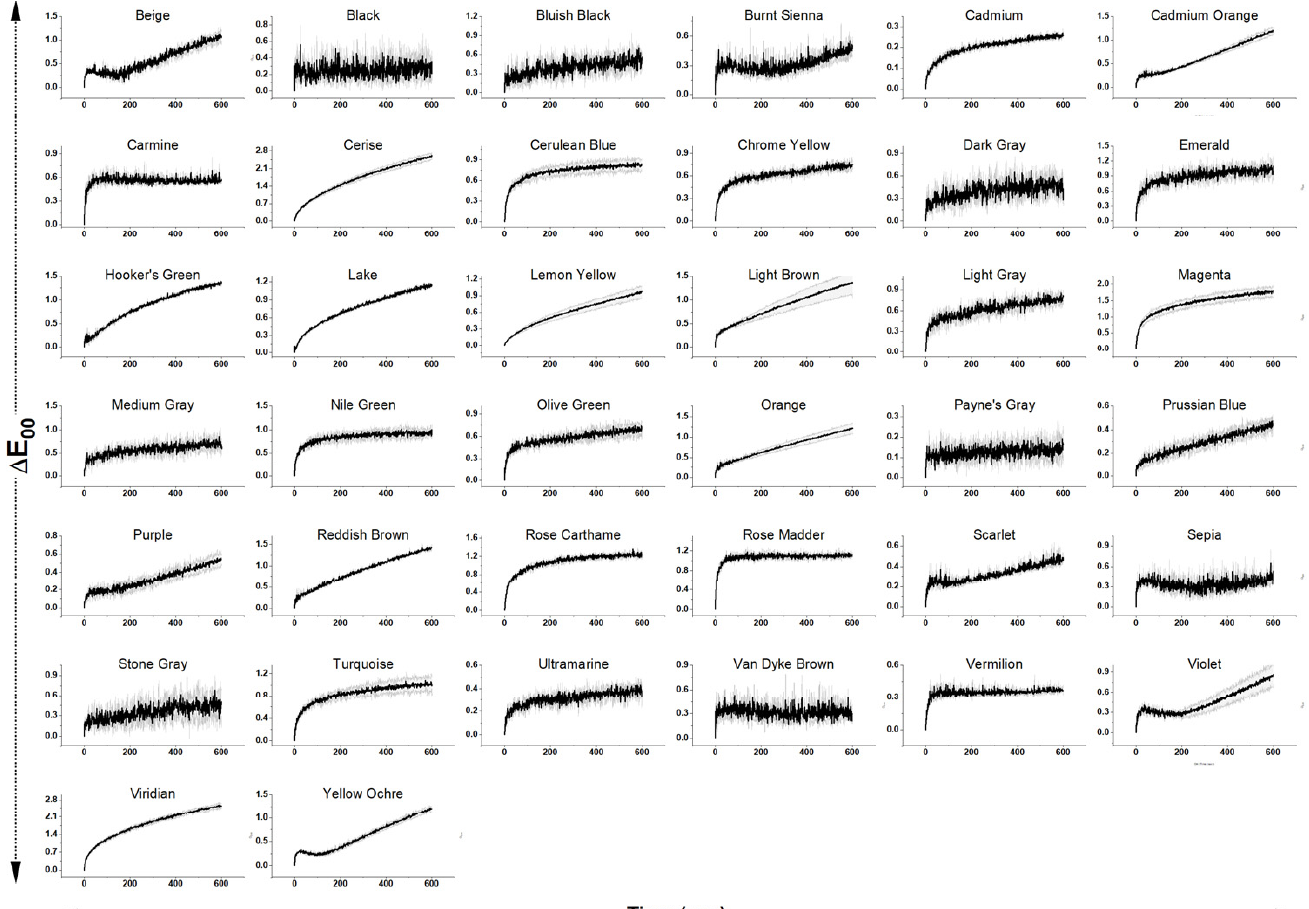
Figure 8. MFT curves achieved over 600 sec of illumination for each of the 38 colors in Dr. Ph. Mar- tin’s Synchromatic Transparent Water Colors